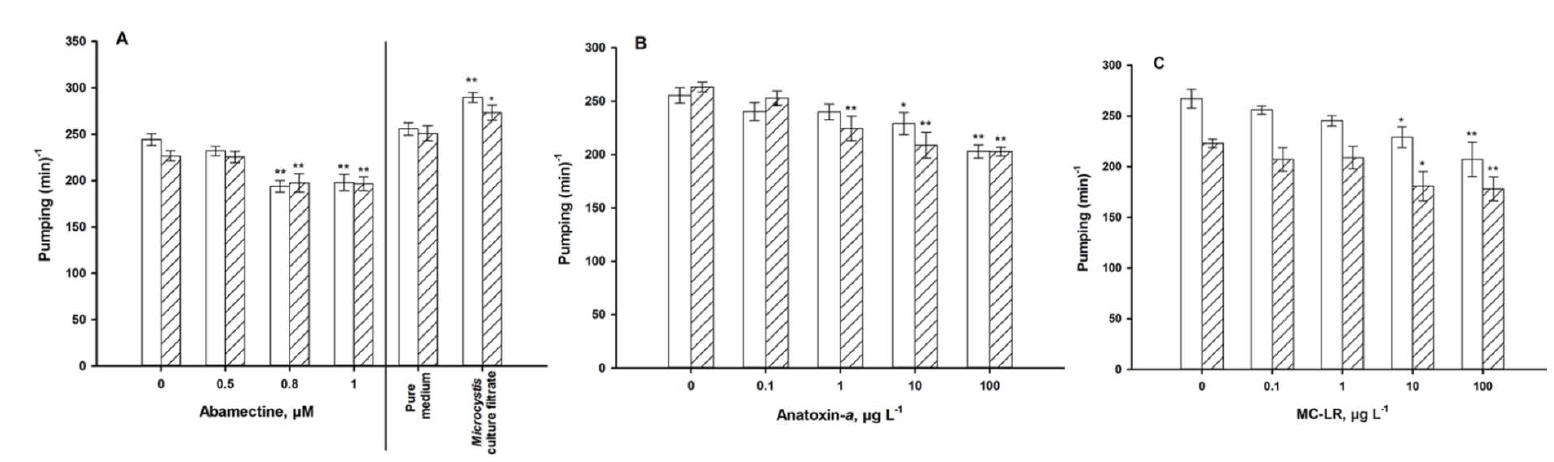
Figure 5. Pharyngeal pumping of young adults for 24 h ( white ) and 72 h ( hatched ). ( A ): exposure to abamectine, and a Microcystis culture filtrate. ( B ): exposure to anatoxin- a . ( C ): exposure to microcystin-LR. * = p < 0.05, ** = p < 0.01.